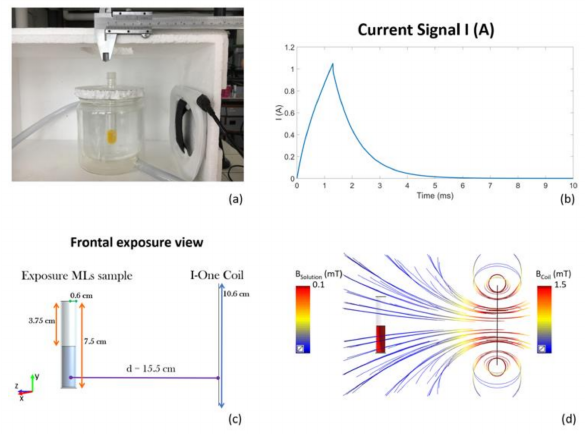
Figure 1. ( a ) pulsed electromagnetic field (PEMF) exposure setup; ( b ) Current signal feeding the coil; ( c ) Model of the high-Tm MLs exposure system in the frontal exposure view; ( d ) Magnetic field distribution in the high-Tm MLs sample given by the magnetic field intensity of the coil